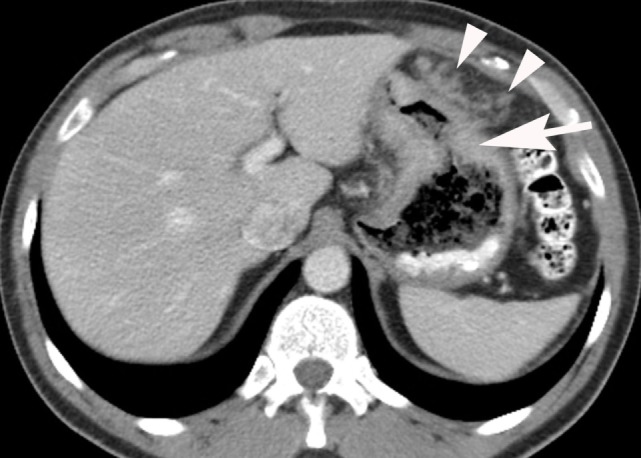
Intravenous and oral contrast material-enhanced computed tomography (CT) showing an adenocarcinoma producing irregular wall thickening of the proximal body of the stomach (arrow) with adjacent omental spread of tumor (arrowheads).